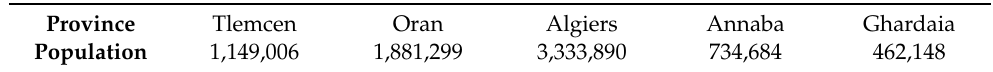
Figure 1. Algerian wilayas (provinces) of Tlemcen, Oran, Algiers, Annaba, and Ghardaia, selected for this study [20–24]. Table 1. Selected wilayas and their 2018 population.